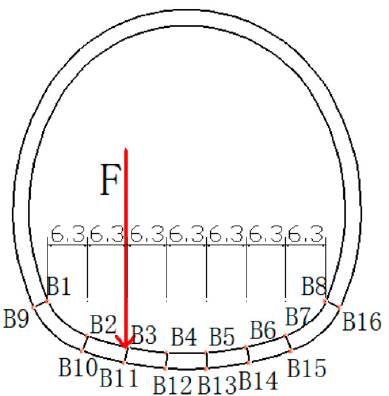
Figure 9. The layout of strain sheet (cm).